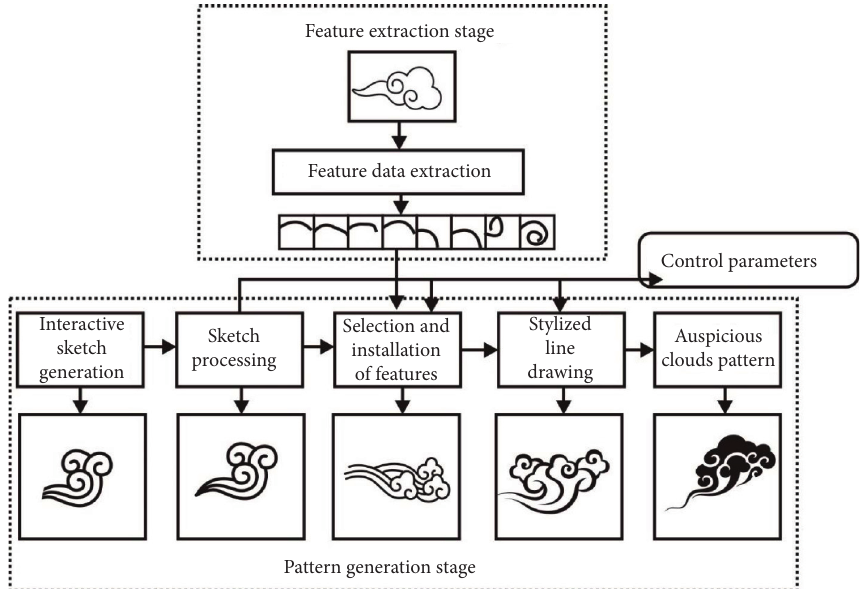
Figure 2: Algorithm